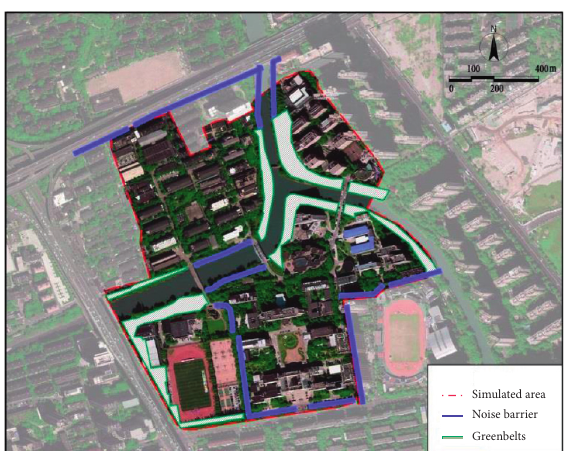
Figure 11: Diagram of setting up combination optimisation of greenbelts and noise barriers in the simulation zones.